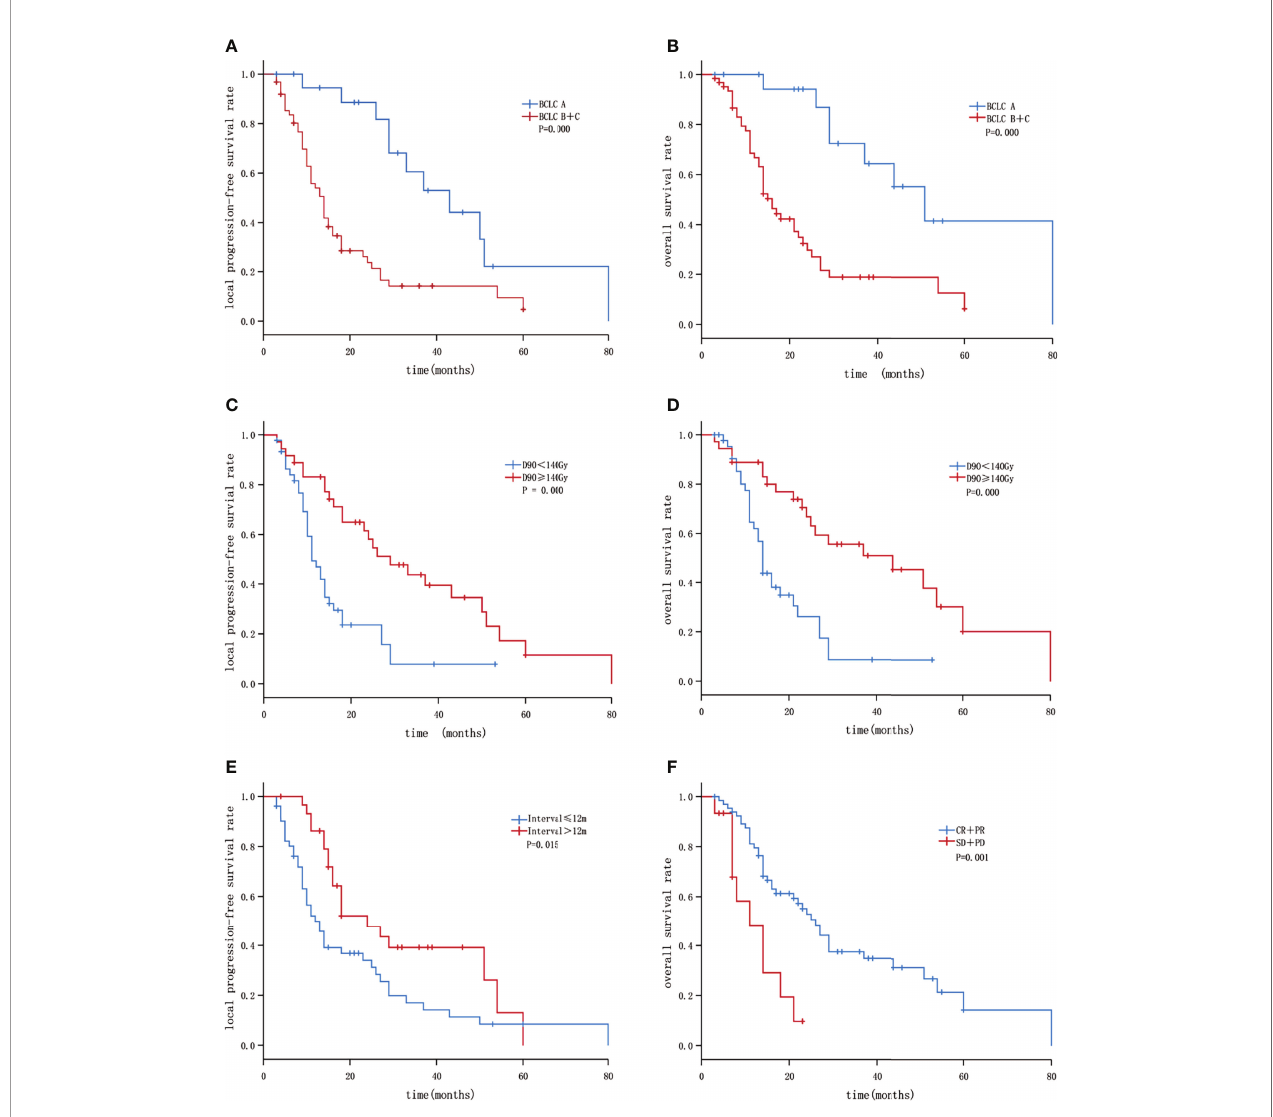
FIGURE 2 | Kaplan – Meier curves showing LPFS and OS: (A) The LPFS of patients with BLCL A and B+C; (B) the OS of patients with BLCL A and B+C; (C) the LPFS of patients with GTV D90 <140 Gy and ≥ 140 Gy; (D) the overall survival of patients with GTV D90<140 Gy and ≥ 140 Gy; (E) the LPFS of patients with Interval ≤ 12 months and >12 months; (F) the OS of patients with short-term ef fi cacy CR+PR and